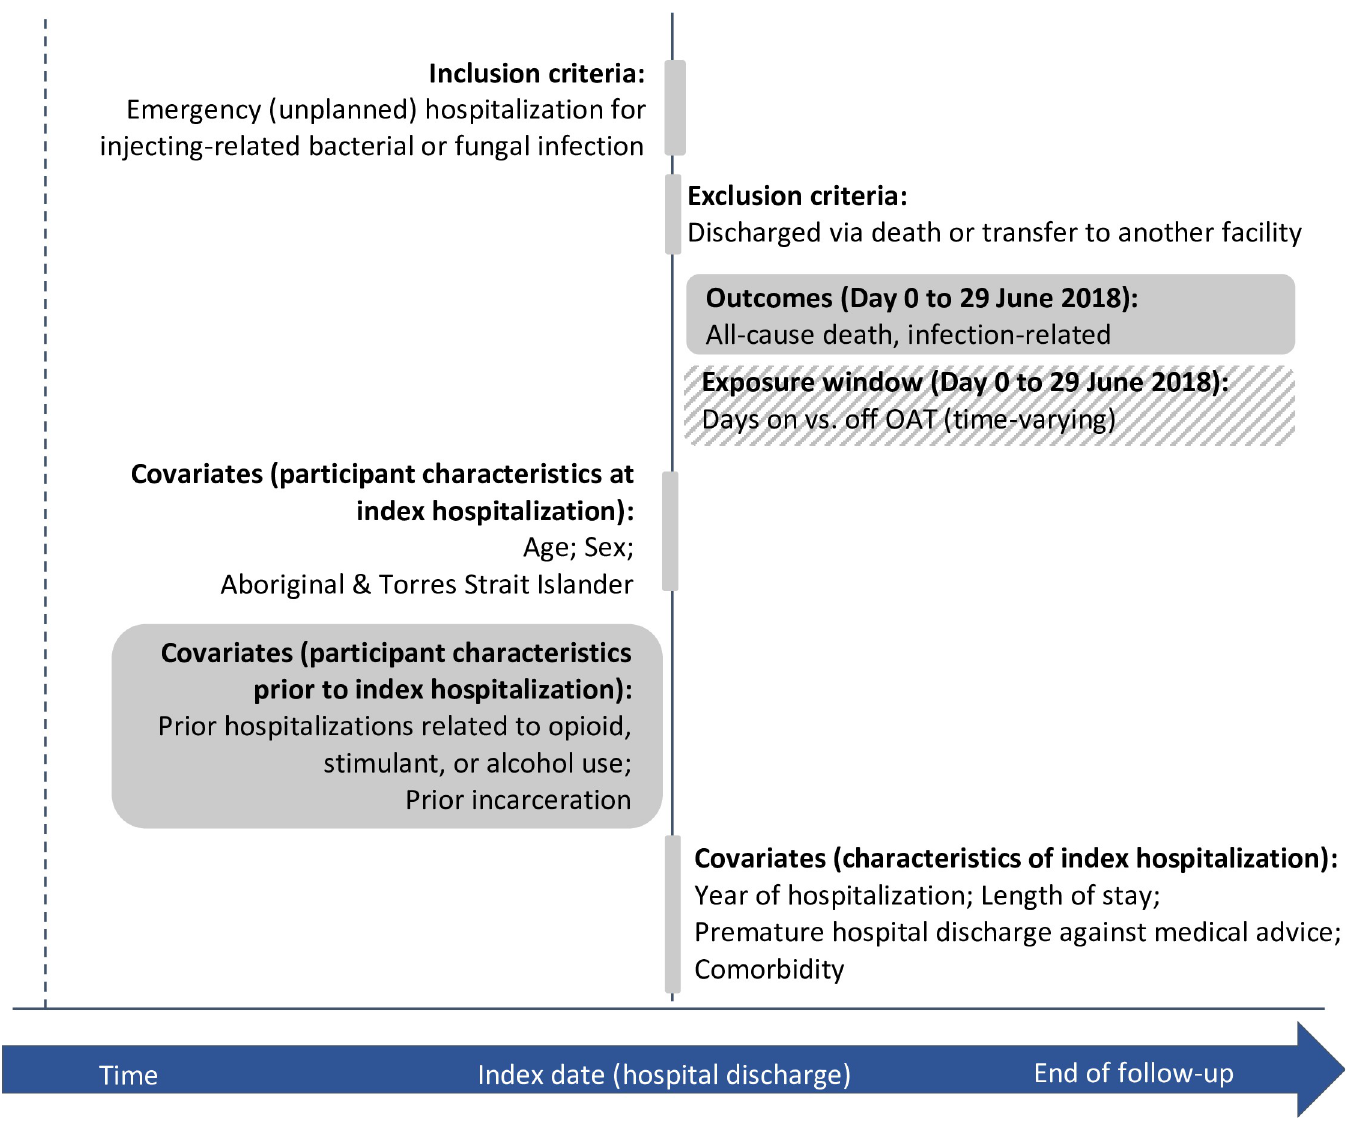
Fig 2. Study design. OAT, opioid agonist treatment.